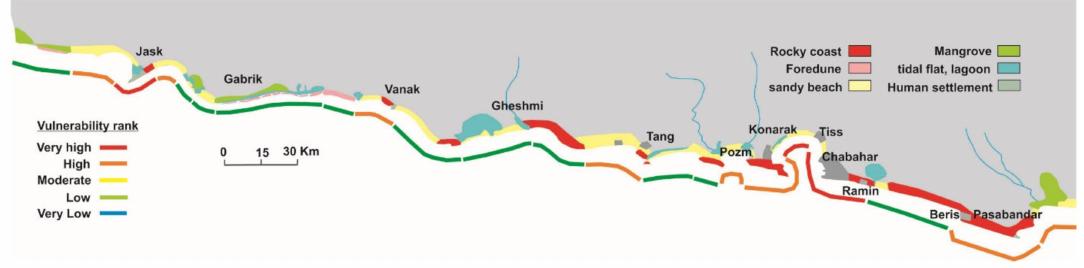
Figure 9. Risk rating of the Iranian coast of Makran based on socioeconomic